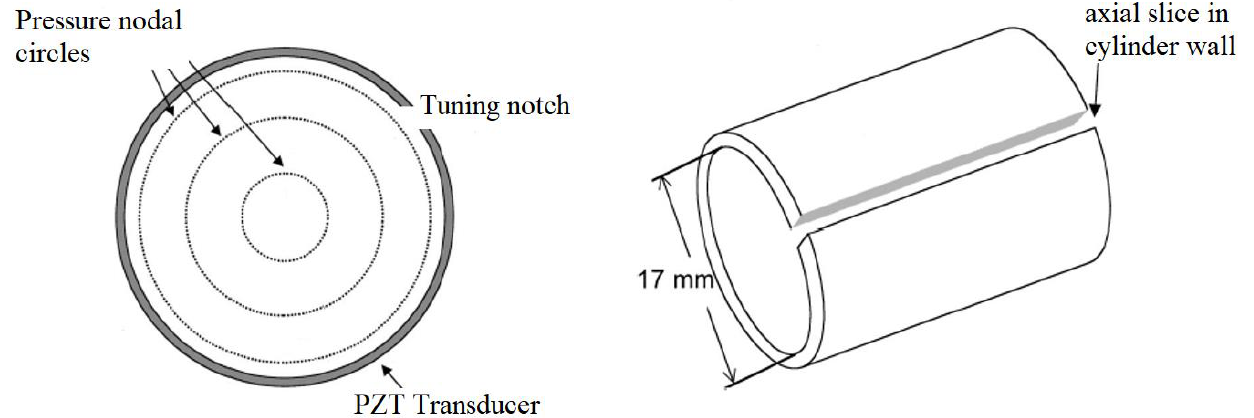
Figure 2. Structural tuning of the piezoelectric transducer by cutting a notch along the length (pressure node circles are illustrated as well); two views are depicted [45].